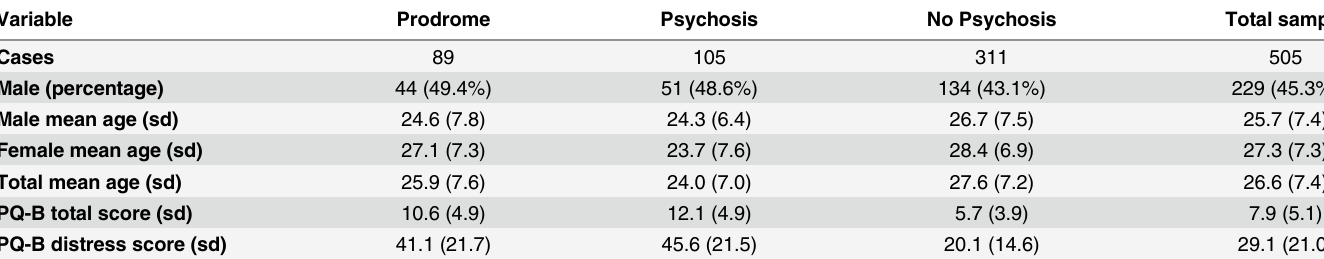
Table 2. Demographic characteristics and PQ-B total and distress